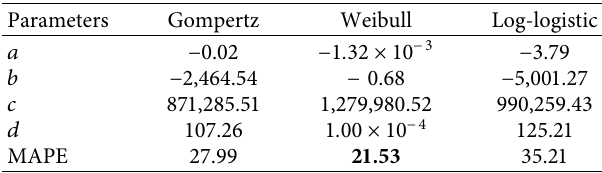
Table 1: Values of the parameters estimated for the three growth models studied when ftting the number of people infected ac- cumulated by COVID-19 in Chile. Te last row contains the MAPEs for the various